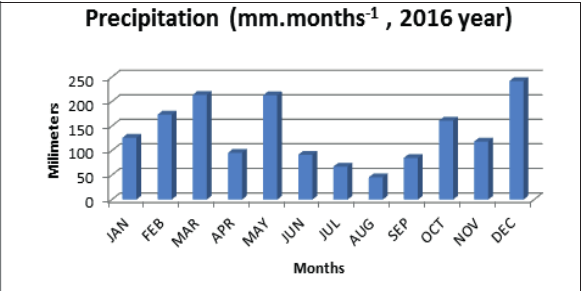
Figure 4. Monthly rainfall distribution during 2016 in Santo Tomas, Yurimaguas.